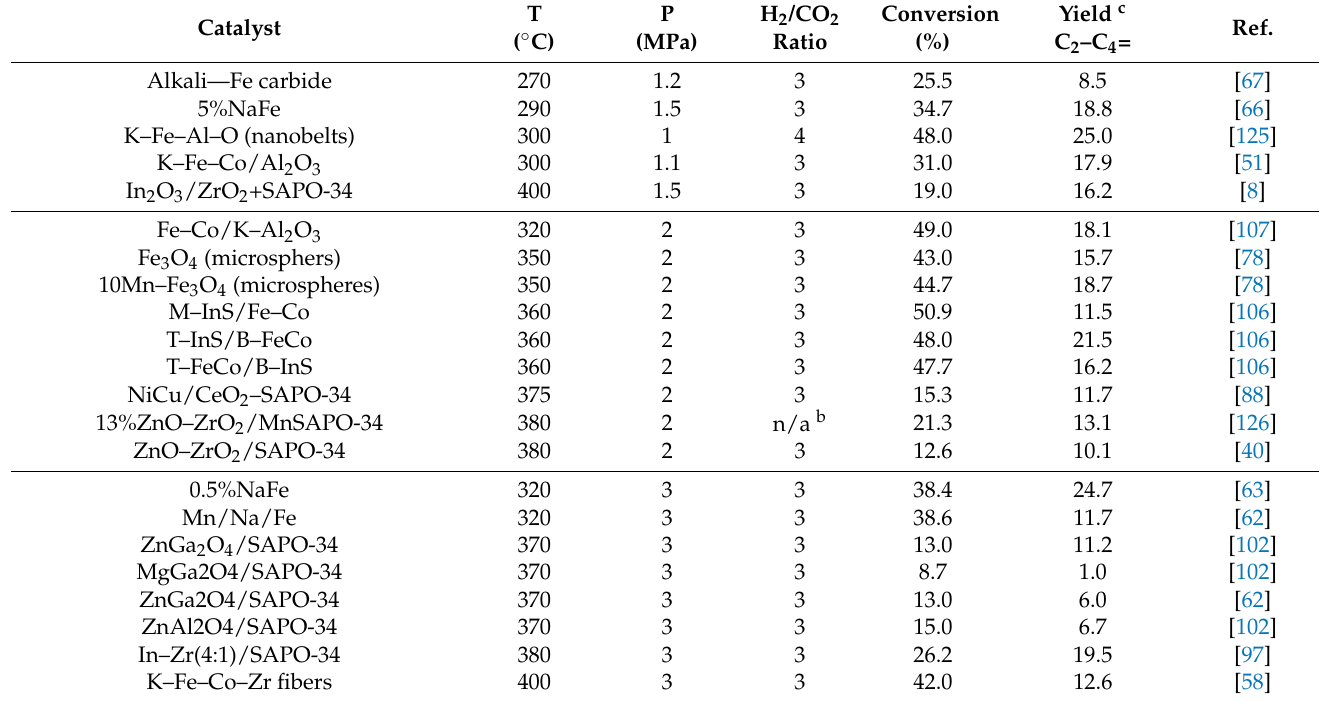
Table 2. Comparison of promoter effect on catalyst efficiency for the formation of C 2= –C 4= olefins via CO 2 hydrogenation a . Catalyst